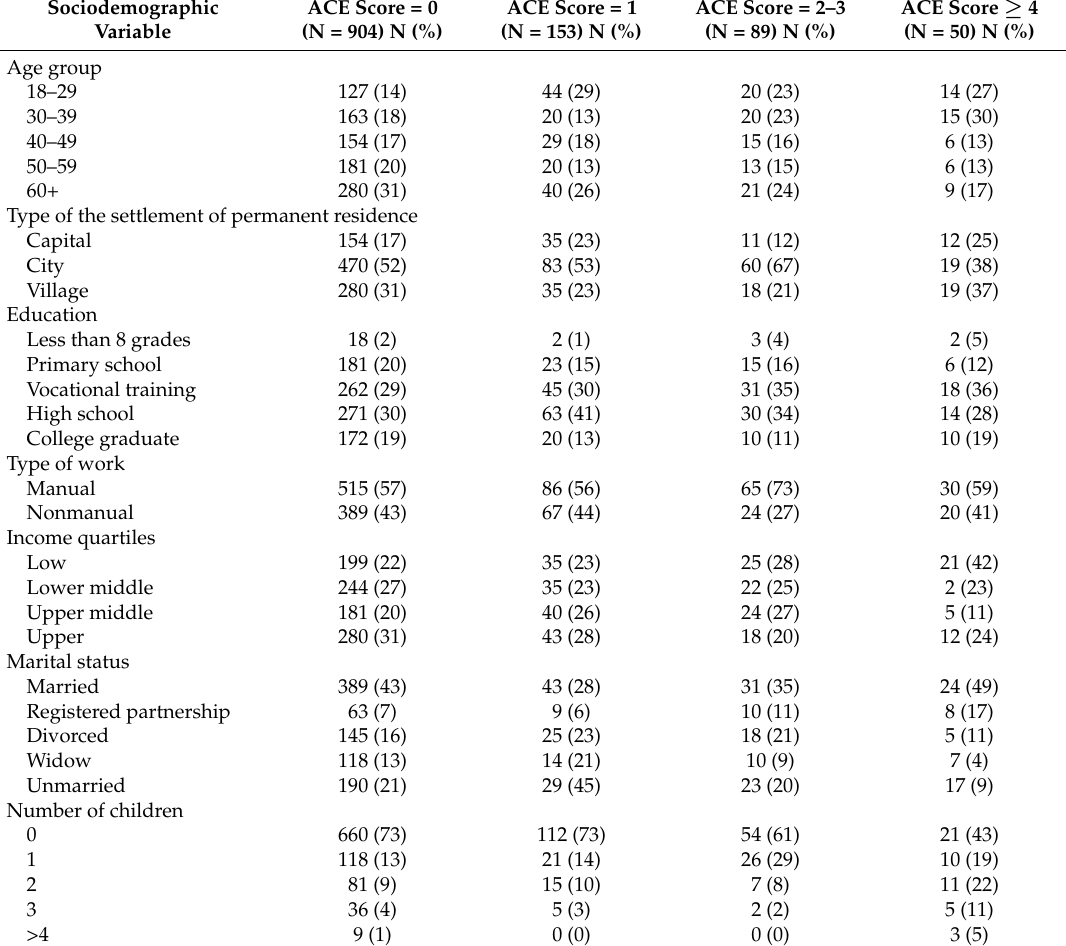
Table 4. Distribution of sociodemographic characteristics by ACE